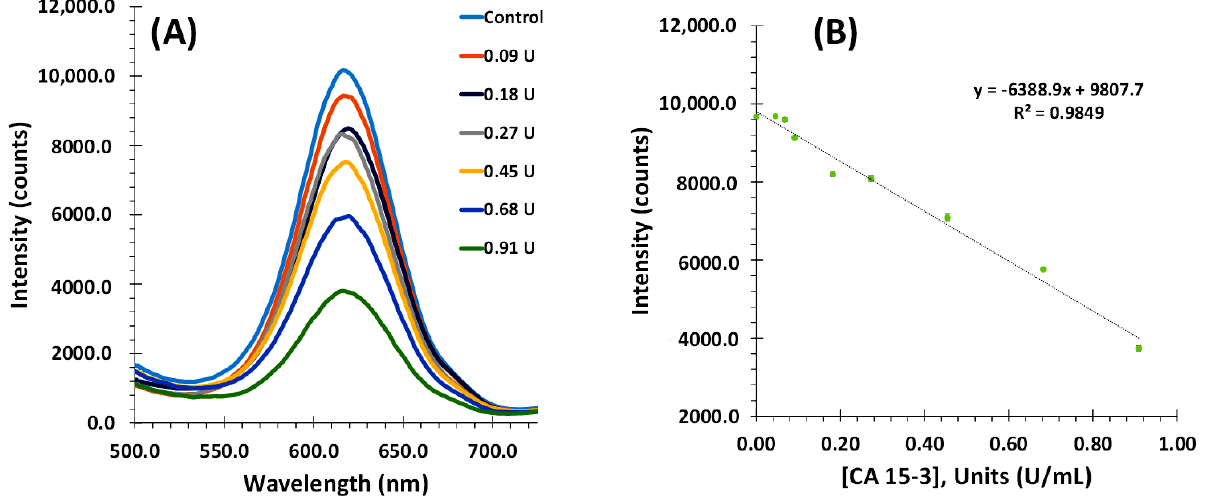
Figure 6. ( A ) Emission spectra of QD conjugates during protein recognition. ( B ) The calibration curve was performed in 10-fold diluted commercial human serum. The analysis was conducted using a photomultiplier tube voltage of 410 PMT and an excitation wavelength of 380 nm (n = 3). Overall, fluorescence emission decreased in the presence of the target and provided a linear regression with a correlation coefficient greater than 0.98. The developed CA 15- 3 biosensor showed a linear response between 0.09 U/mL and 0.91 U/mL.